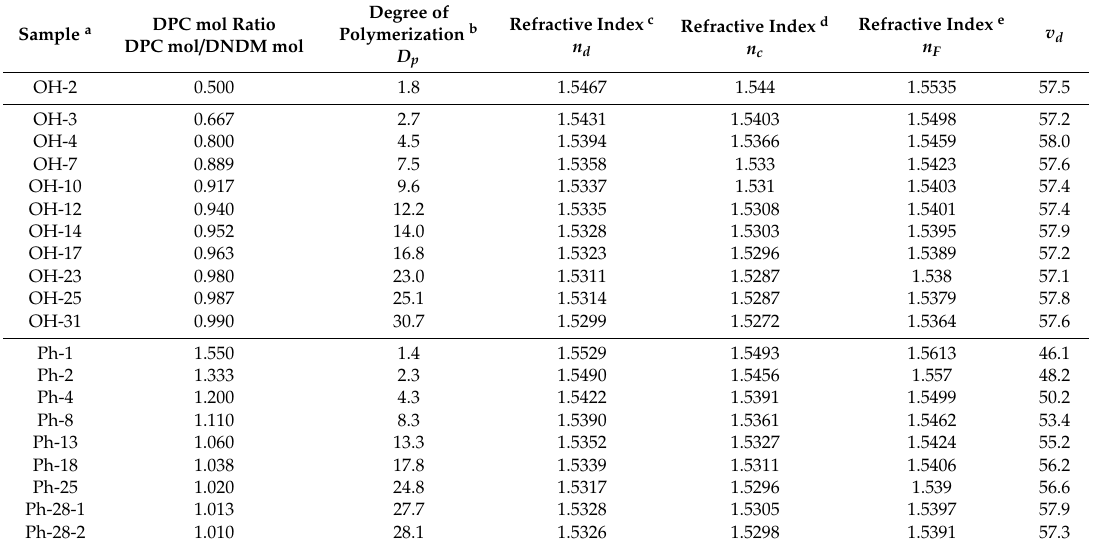
Table 1. Numerical data of hydroxy end group (OH-n) and phenolic end group (Ph-n) of DNDM monomers, oligomers, and polymers discussed, including refractive indices n and abbe number v d on D p. Sample a